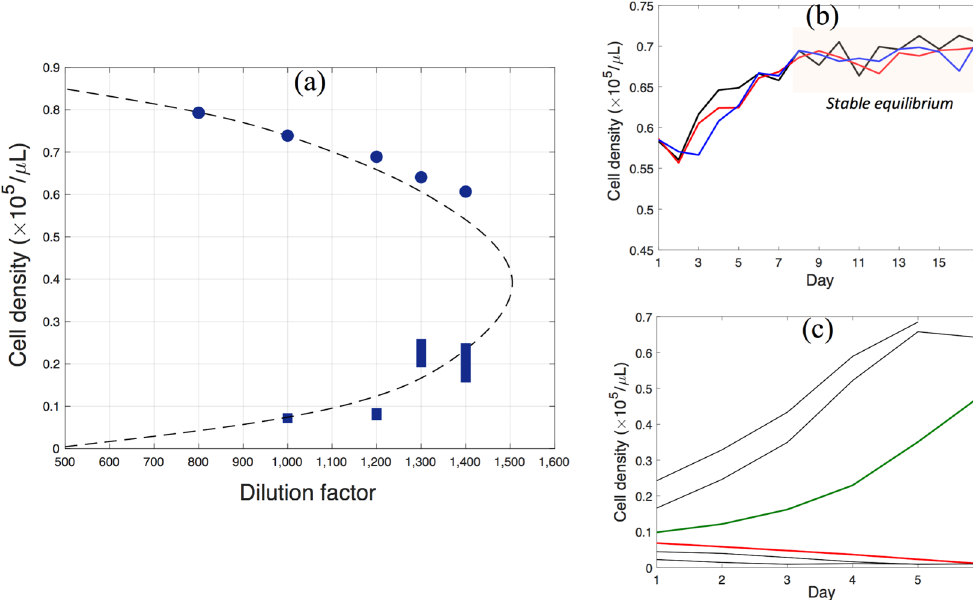
Figure 3. ( a ) Estimated bifurcation diagram of the buddying yeast system. Circles represent experimentally measured stable population densities at selected dilution factors obtained by averaging the populations which are at equilibrium over at least five days. Vertical bars represent experimentally approximated regions containing unstable fixed points at selected dilution factors, obtained by monitoring the population growth starting from several initial densities. Thus, the region between two initial conditions resulting in survival and extinction of the population is identified. ( b , c ) The experiments performed at the dilution factor of 1,200 to identify the corresponding stable and unstable fixed points on the bifurcation diagram are depicted. The dashed line is the approximated bifurcation diagram using the calibrated model. The dilution factor at the tipping point is approximately 1,505. This bifurcation diagram is used as a reference to validate the forecasting results presented in the following